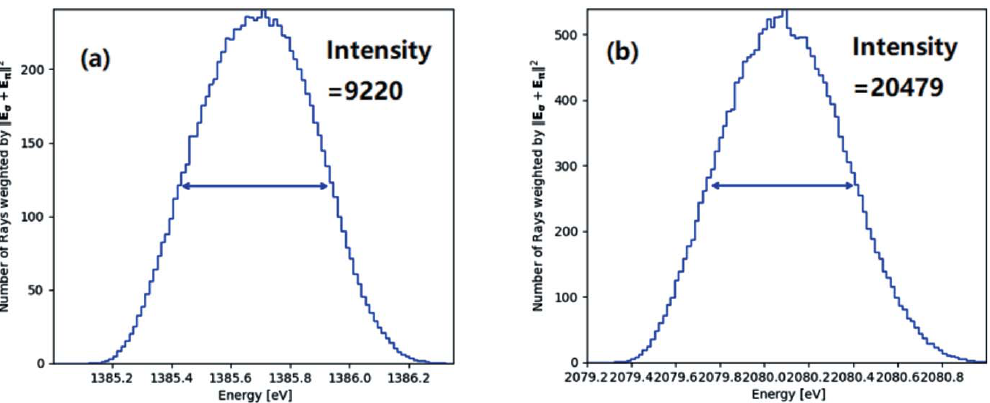
Figure 8 Plots of ray-tracing calculation results with five million rays for the DCM of YB 66 (004) around 1385.6 eV ( a ) and YB 66 (006) around 2080 eV ( b ). The input bandwidths around 1385.6 eV and 2080 eV are 0.097% and 0.086%,